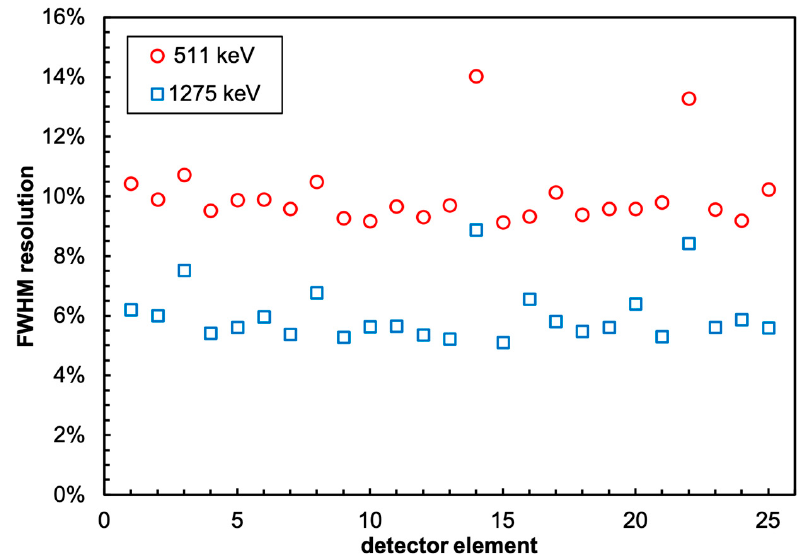
Figure 9. The 25 calibrated spectra in the configuration with the lead collimator.